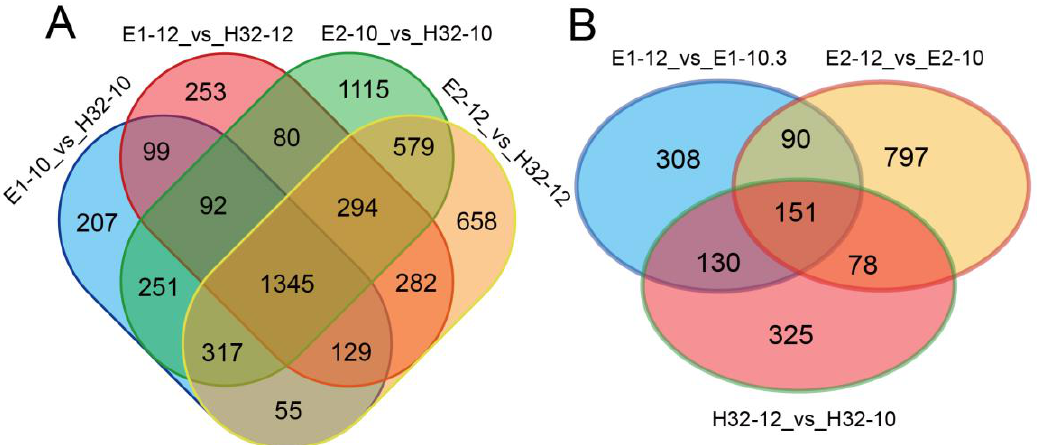
Figure 2. Venn diagram of DEGs. ( A ) Venn diagram of DEGs in different cultivars ( B ) Venn diagram of DEGs between 10:00 and